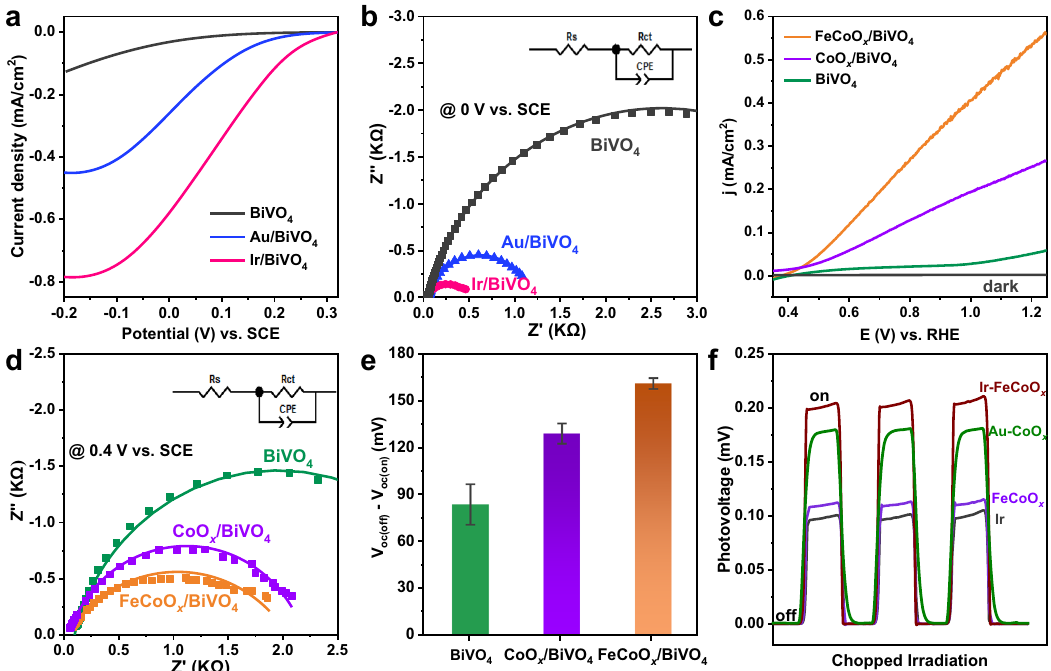
Fig. 3 Electrochemical measurements and characterizations of typical samples. a Linear sweep voltammetry curves of typical samples in the 100 mM sodium phosphate buffer solution (pH 6.0) containing 5 mM K 3 [Fe(CN) 6 ]. b EIS spectra of typical samples in a 100 mM sodium phosphate buffer solution (pH 6.0) containing 5 mM K 3 [Fe(CN) 6 ]. SCE, saturated calomel electrode. c Photocurrent density-potential curves of BiVO 4 , CoO x /BiVO 4 , and FeCoO x / BiVO 4 . d EIS spectra of BiVO 4 , CoO x /BiVO 4 , and FeCoO x /BiVO 4 in a 100 mM sodium phosphate buffer solution (pH 6.0). e Comparison of difference of OCPs on the BiVO 4 , CoO x /BiVO 4 , and FeCoO x /BiVO 4 under dark and illumination conditions. Measurements were taken at least three times for separate samples and average values are presented with the standard deviation as the error bar. f Comparison of promotion effect of cocatalysts on the SPV values of the BiVO 4 photocatalyst under chopped visible light